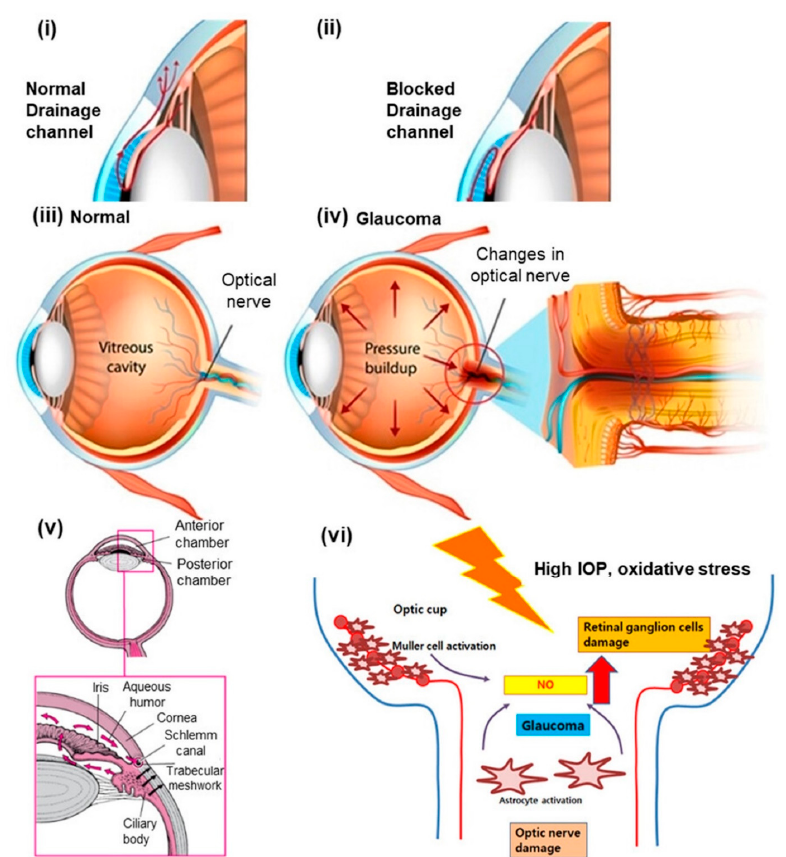
Figure 1. Schematic illustration presenting the pathophysiology of the eye in glaucoma compared to normal eyes. ( i ) Normal drainage channel in healthy eye . ( ii ) Blocked drainage channel in glau- coma. ( iii ) Normal IOP in a vitreous cavity and normal optical nerve in a healthy eye. ( iv ) Rise in IOP in a vitreous cavity and changes in the optical nerve in glaucoma. ( v ) Ocular fluid is produced in a posterior chamber at the ciliary body behind the iris and flows through the anterior chamber of the eye to ultimately come out through the uveoscleral pathway (highlighted by the black arrow). ( vi ) Rise in IOP and oxidative stress in the glaucoma-conditioned eye finally led to damage to retinal ganglion cells and optical nerves. Reproduced from Patel et al. [10], Elsevier, 2022.